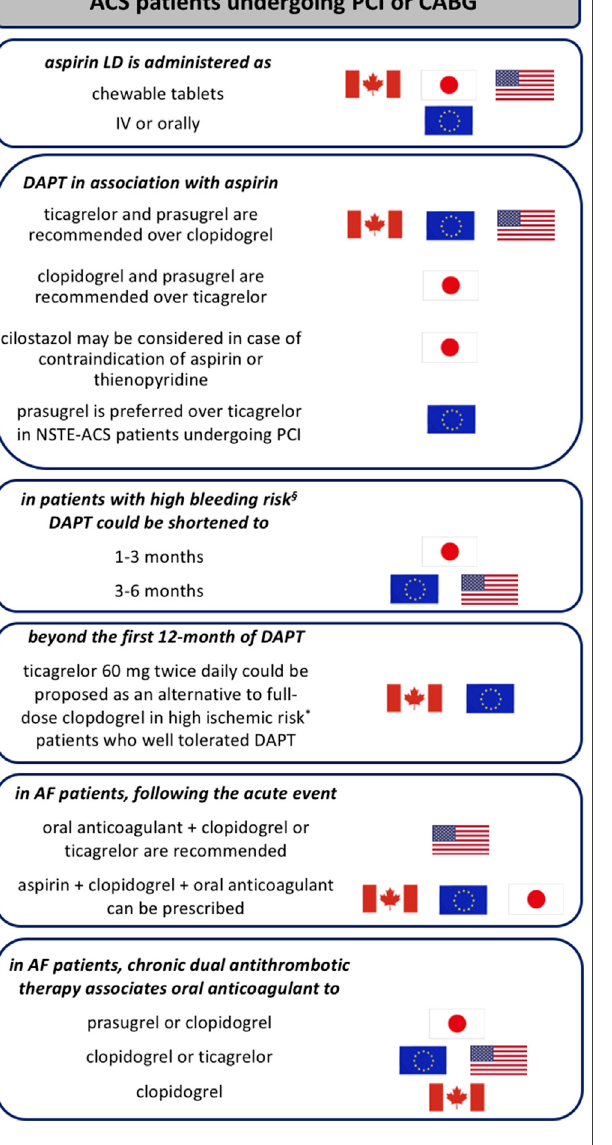
FIGURE 1 | ( > 60 mm total stent length), complex lesions (bifurcation treated with 2 stents, stenting of chronic occlusion), left main or proximal left anterior descending artery stenting or multivessel PCI) (Canadian guidelines); having prior stent thrombosis on adequate antiplatelet therapy, stenting of the last remaining patent coronary artery, diffuse multivessel disease especially in diabetic patients, chronic kidney disease (with creatinine clearance < 60 ml/ min), at least three stents implanted, at least three lesions treated, bifurcation withtwostents inplanted, total stentlength > 60 mm, ortreatment ofachronic total occlusion (European guidelines). ACS: acute coronary syndrome; AF: atrial fi brillation; CABG: coronary artery bypass graft; DAPT: dual antiplatelet therapy; LD: loading dose; NSTE: non-ST elevation; PCI: percutaneous coronary